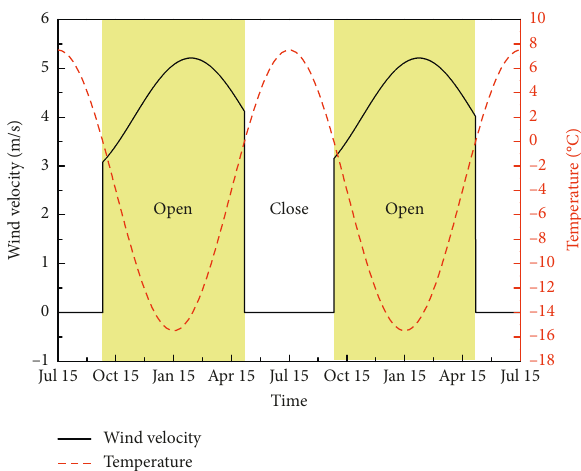
Figure 15: Working status of the duct-ventilated tower foundation.